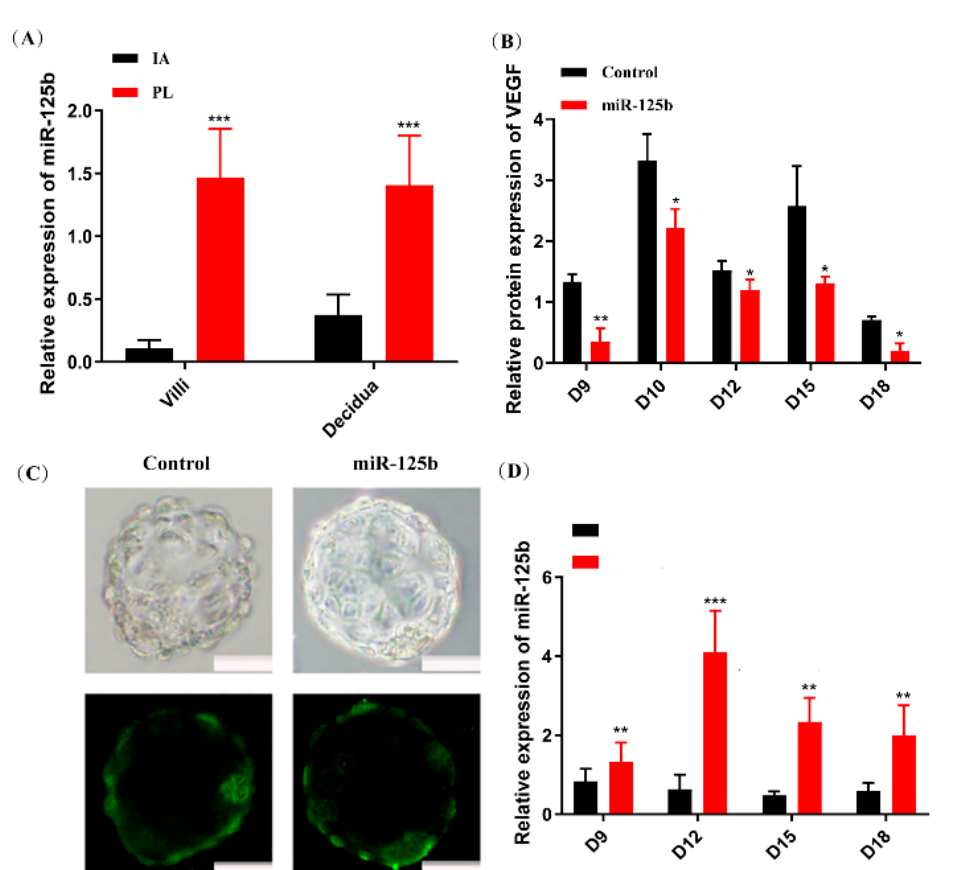
Figure 1. An effective miR-125b expression in PL placentas and mouse model placenta caused by trophoblast-specific miR-125b overexpression. ( A ): The expression of miR-125b in the decidua and villi of 10 PL and IA patients by RT-qPCR. Data were presented as mean ± SEM (*** p < 0.01, vs. IA); ( B ): the protein expression of VEGF in placenta on different pregnancy days in mice by ELISA. Data were presented as mean ± SEM, n = 10 (* p < 0.05, ** p < 0.01, vs. control); ( C ): Blastocysts transduced with lentiviruses expressing GFP control and miR-125b; Scale bars: 20 µ m; ( D ): the expression of miR-125b in placenta of different pregnancy days mice by RT-qPCR. Data were presented as mean ± SEM, n = 10 (** p < 0.01, *** p < 0.001).